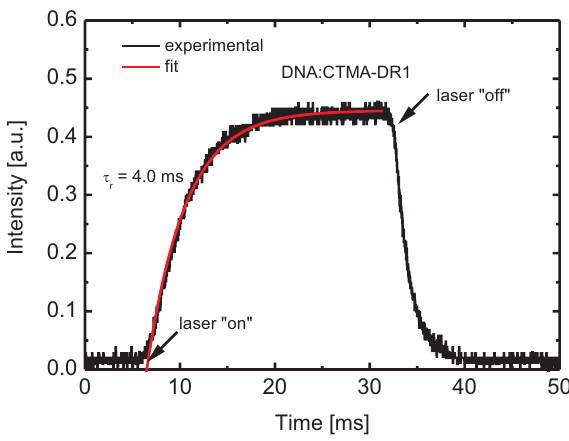
Figure 2. Time evolution of measured intensity for DR1:DNA-CTMA system in a short time interval. Solid line –single exponential